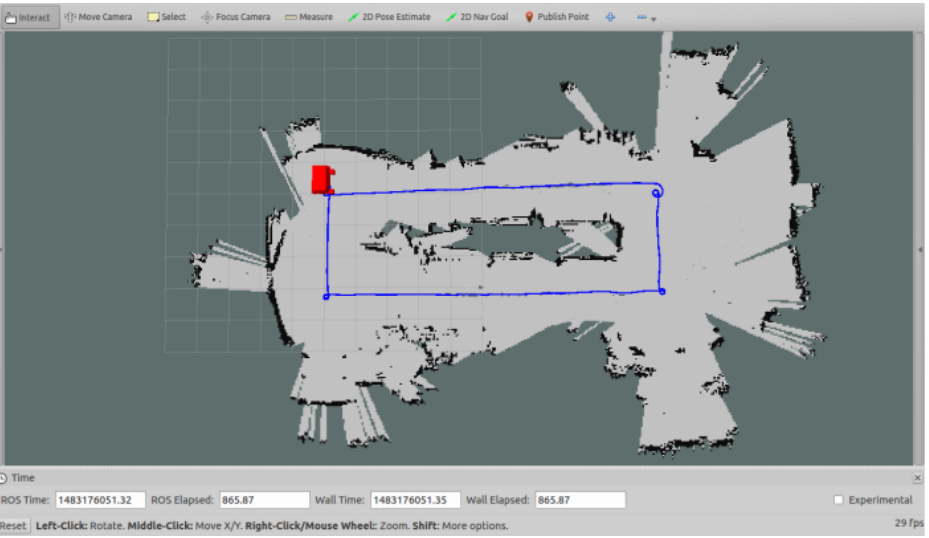
Figure 13. Localization and mapping in the production line.